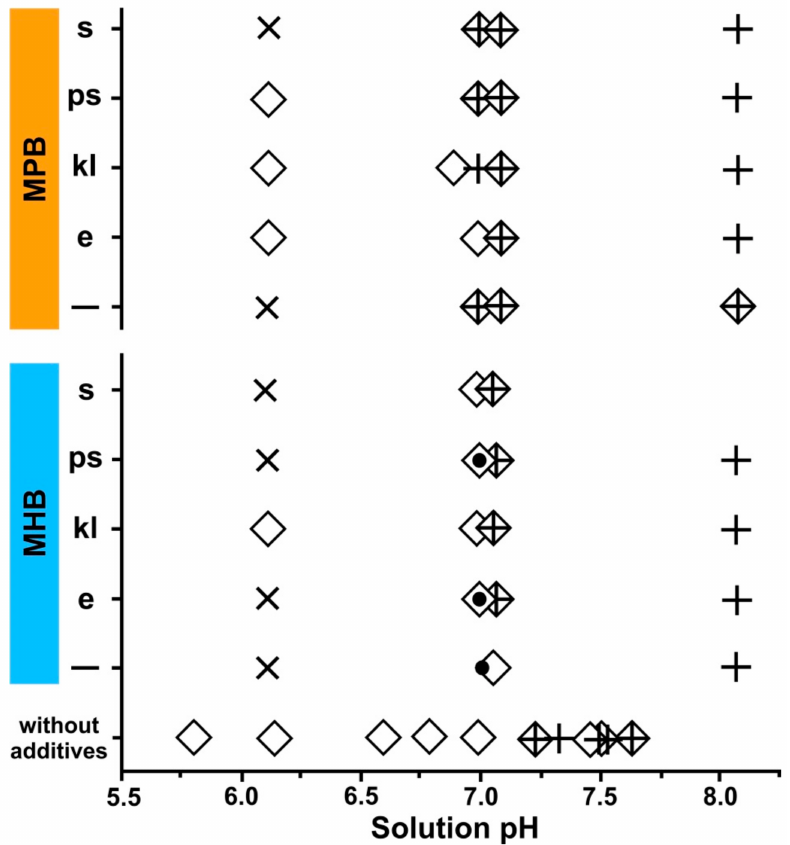
Figure 4. Phase composition of synthesized products from model solutions with maximum concentrations of additional ions characteristic of a healthy person’s urine composition. Legend as in Figure 3.